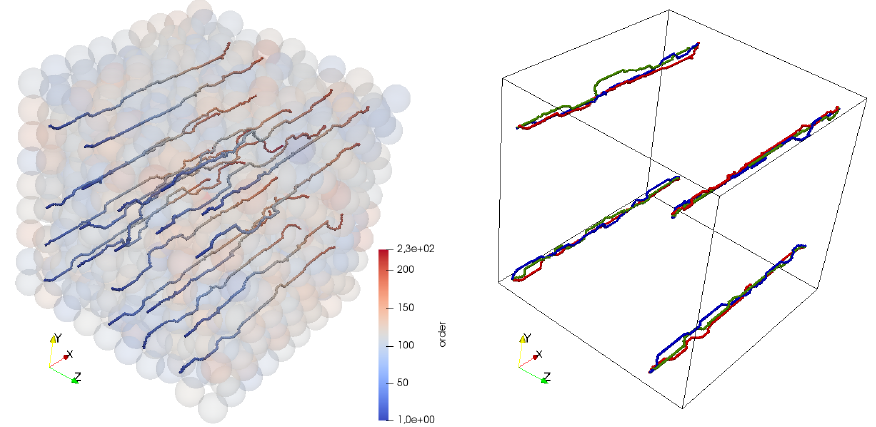
Figure 11. Paths calculated by the A-Star Algorithm in static variant (resolution 200 × 200 × 200).